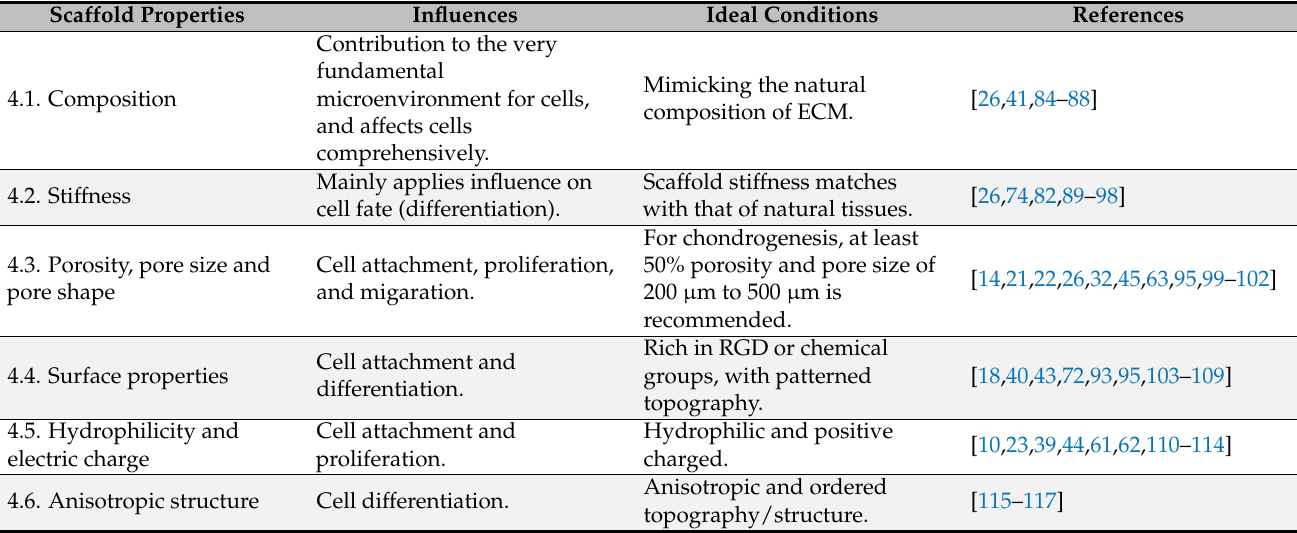
Table 2. Summary of the influences and ideal conditions of different scaffold